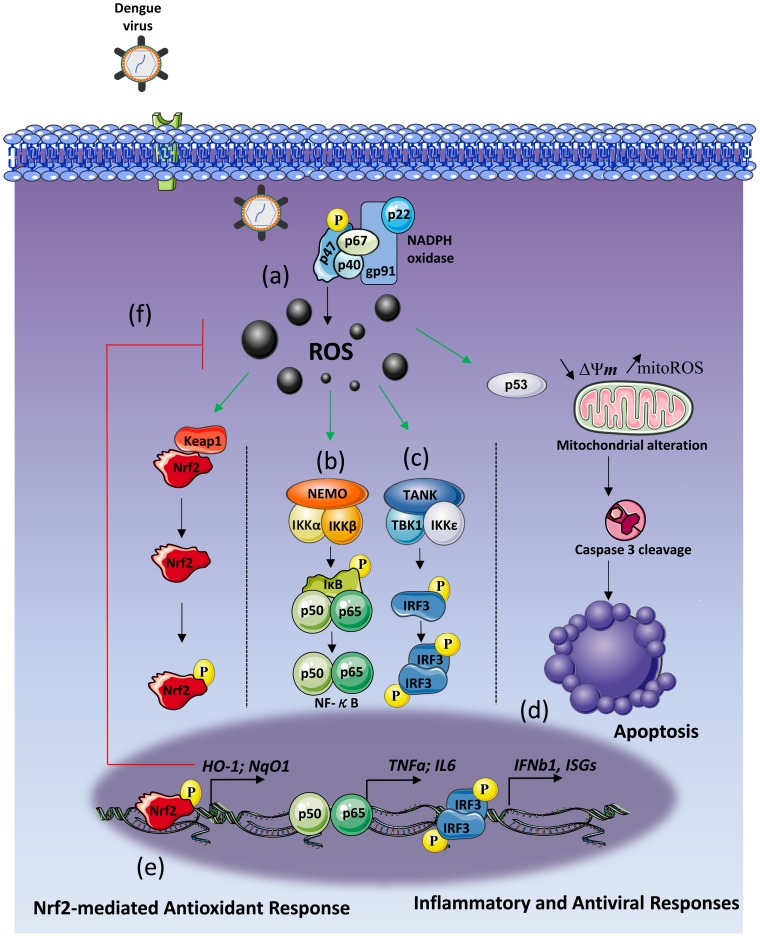
Schematic of DENV induces NOX-dependent ROS production required for antiviral and apoptotic responses.DENV2 infection generates intracellular NOX-derived ROS accumulation in Mo-DC (A). DENV2-induced ROS formation is essential for the activation of the NF-κB inflammatory response (B) and for the IRF3-mediated antiviral response (C). ROS accumulation leads to p53 stimulation which generates a mitochondrial and caspase-dependent apoptosis (D). Finally, oxidative stress generation also stimulates the cytoprotective transcription factor Nrf2 (E) which tightly regulates ROS levels (f) as well as innate immune and apoptotic responses to DENV infection.